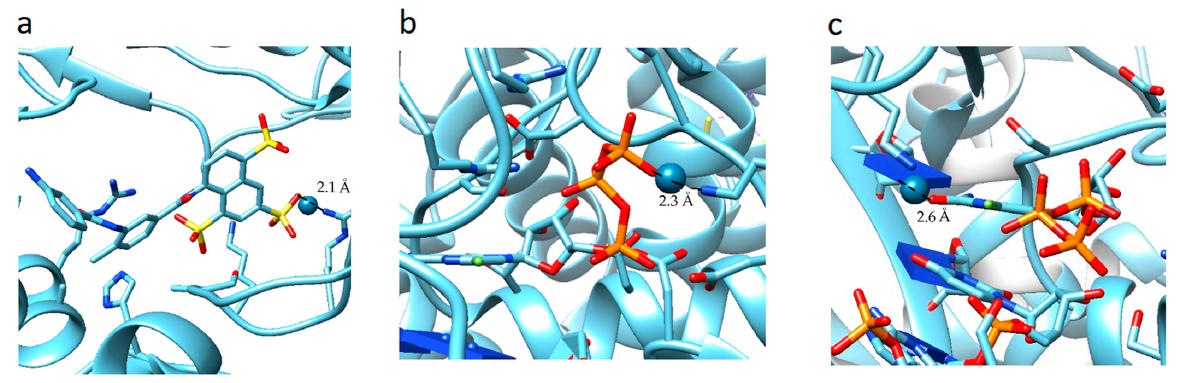
Figure 4. Location of point corresponding to the maximum complementarity factor (fc) for complexes: 7D4F, 7CTT, 7AAP: ( a ) 7D4F, 2.1 Å is the distance between the sulfo group of suramin and the guanidine component of arginine, ( b ) 7CTT, 2.3 Å distance between protease lysine and triphosphate group of favipiravir-RTP, ( c ) 7AAP, 2.6 Å distance between RNA cytosine and oxygen of the amide group of favipiravir-RTP.